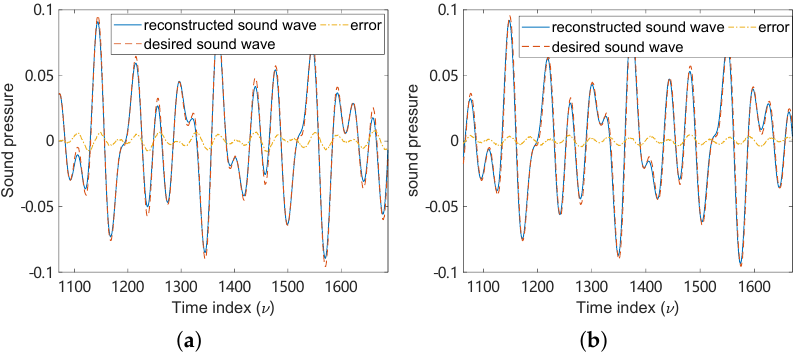
Figure 8. Comparison between reconstructed sound pressure and desired sound pressure at the point ( a ) ( − 0.13,0.07,0.02 ) m and ( b ) ( − 0.03,0.01,0.1 )